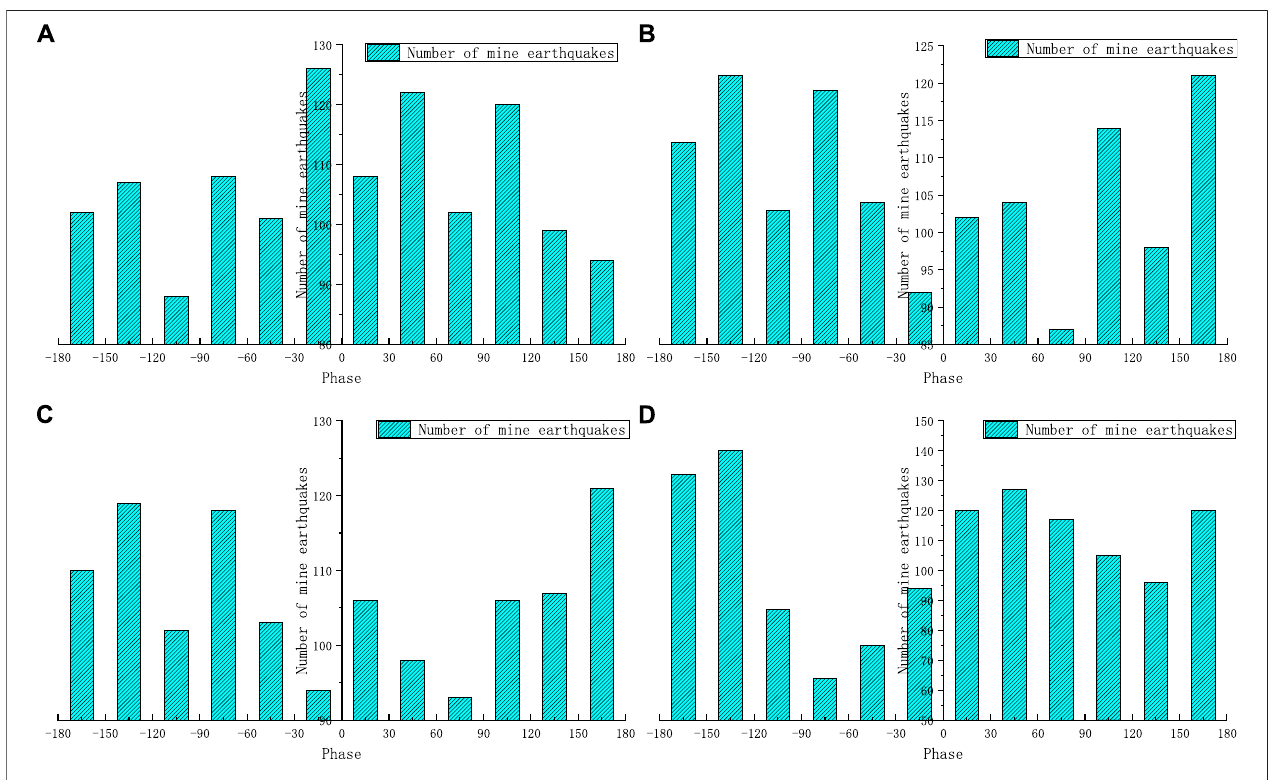
FIGURE 5 | Statistical histogram of the mine earthquake 0 ≤ M L < 0.5